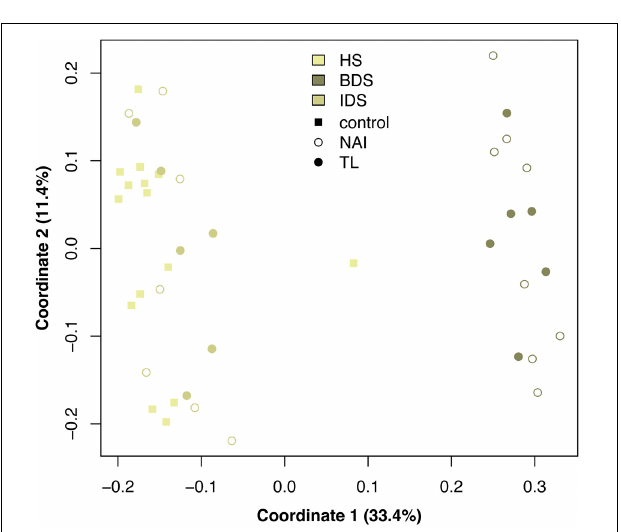
FIGURE 3 | Principal coordinates analysis of microbial communities among sediment treatments and sample conditions, based on Bray–Curtis dissimilarity among samples. Treatment abbreviations as in Table 1 and treatment colors as in Figure 1